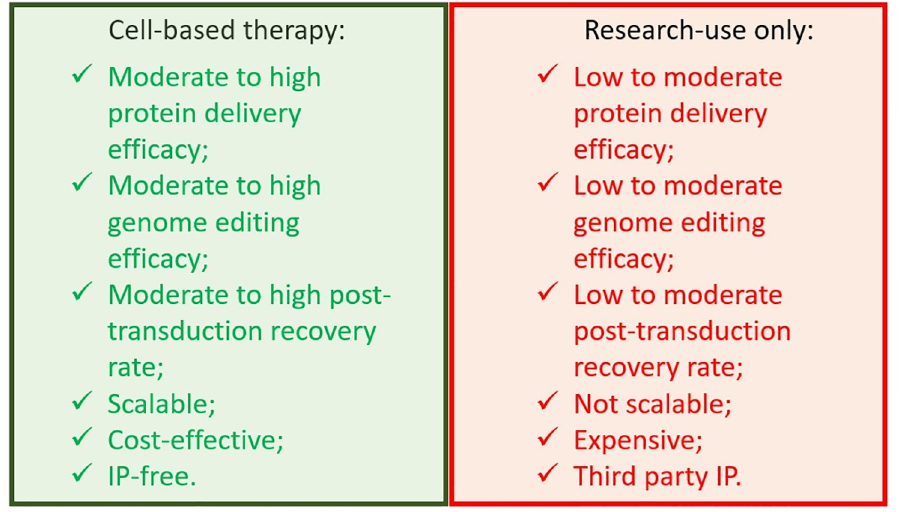
Fig 1. Features of CRISPR/Cas RNP delivery methods suitable for development of cell-based therapies and those considered ‘research-use only’.